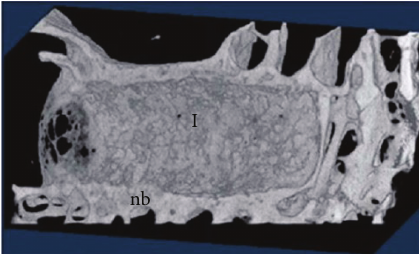
Figure 2: The 3D reconstruction of the bone around a composite C30 implant after 6 months of implantation (with ImageJ software) (I = implant; nb = newly formed bone) (originally adapted from